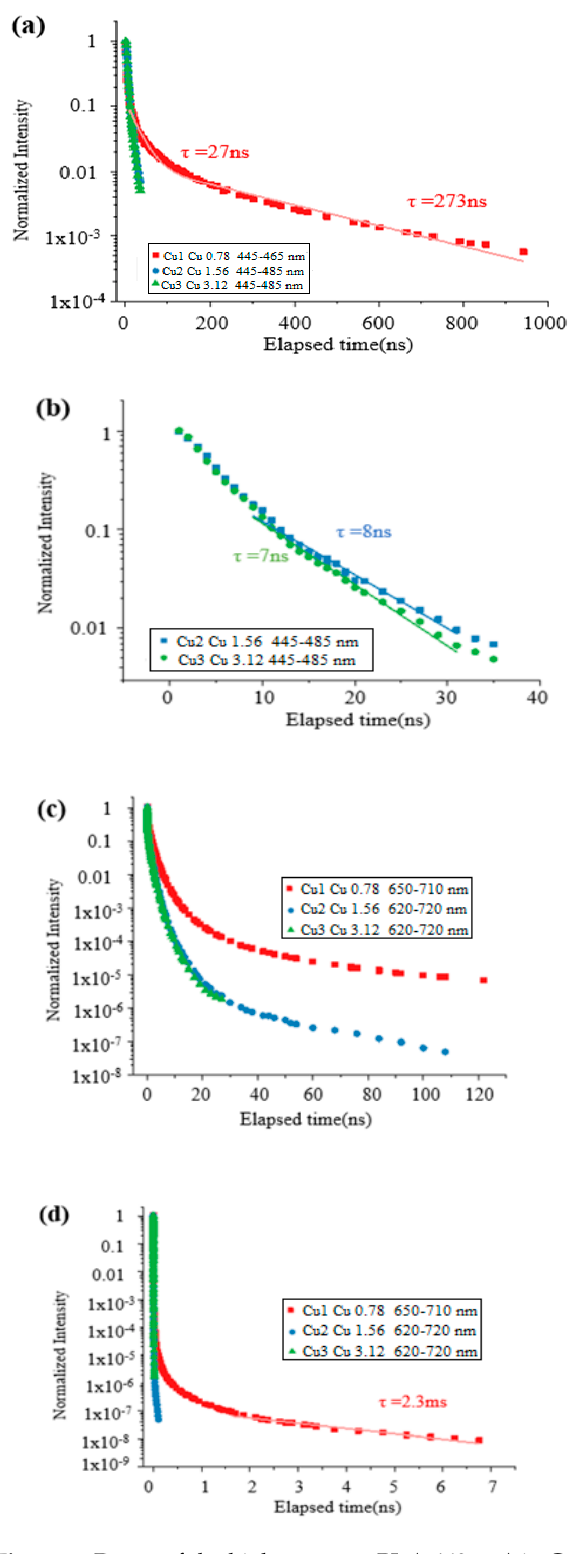
Figure 5. Decay of the higher energy PL (~460 nm) in Cu samples. Here ( a ) QD luminescence of sample Cu1 at 455 nm slower than luminescence band of sample Cu2 and Cu3 around 465 nm, ( b ) The broad luminescence around 465 nm, ( c ) The broad luminescence decay around 660 nm decay and ( d ) The broad luminescence decay around 670 nm